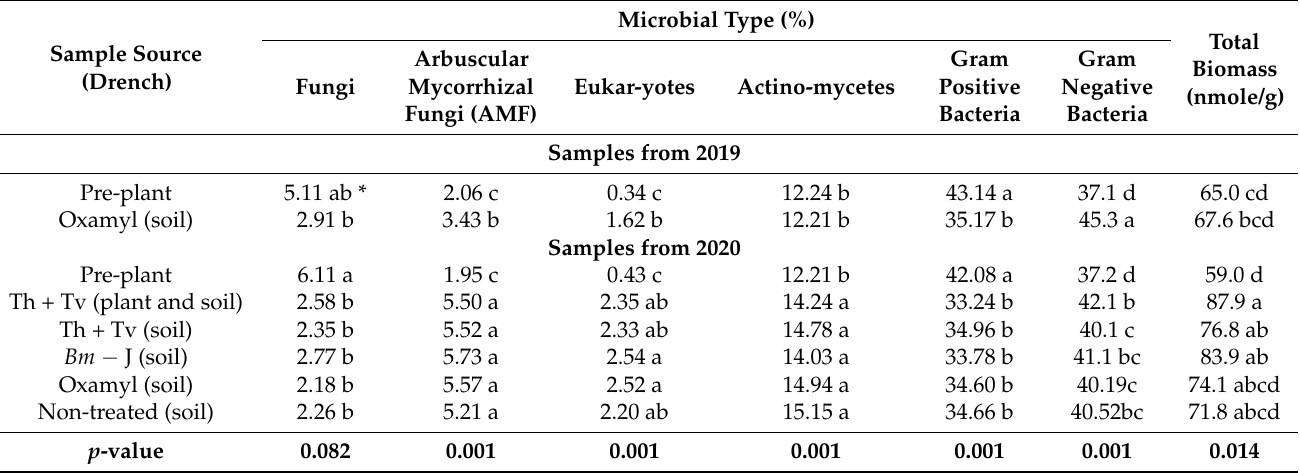
Table 3. Microbial population in soil samples collected pre- and post-treatment studies in the high